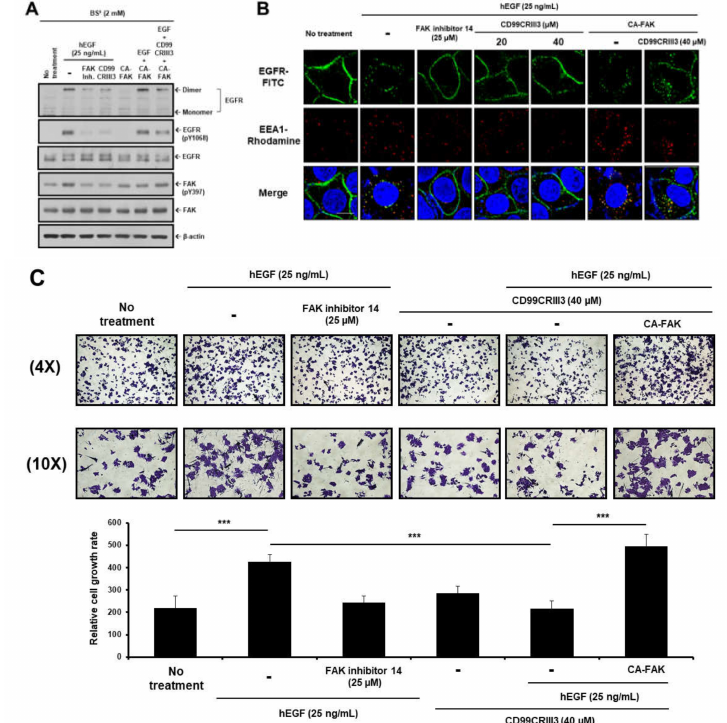
Figure 5. FAK plays an important role in breast cancer cell proliferation induced by EGFR activation. ( A ) MDA-MB-231 cells transfected with CA-FAK plasmid were subjected to BS 3